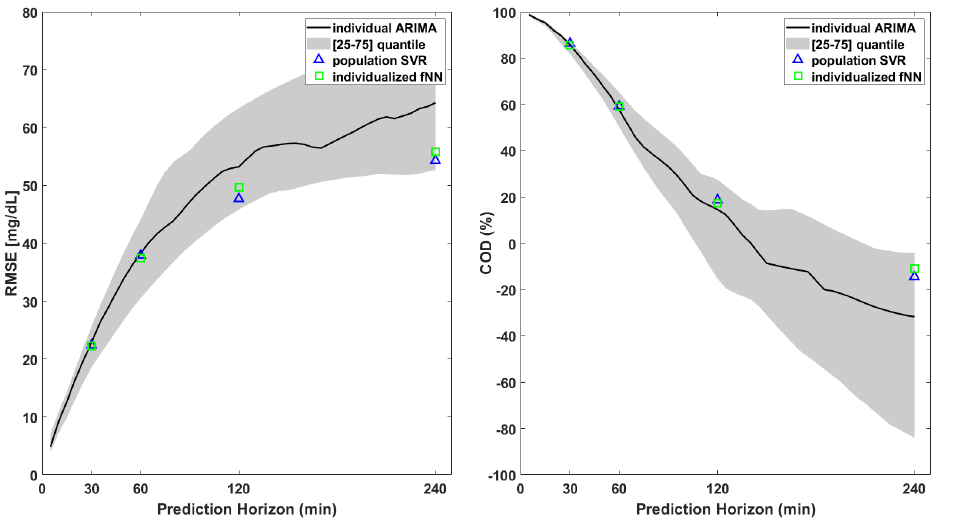
Figure 6. RMSE ( left ) and COD ( right ) for the 3 best-performing algorithms out of the 30 tested in this work. The black lines are the median RMSE and COD (left and right, respectively) obtained using individual ARIMA with different prediction horizons. Blue triangles and green squares indicate the same metrics for PH = 30, 60, 120, and 240 min for population SVR and individualized fNN,